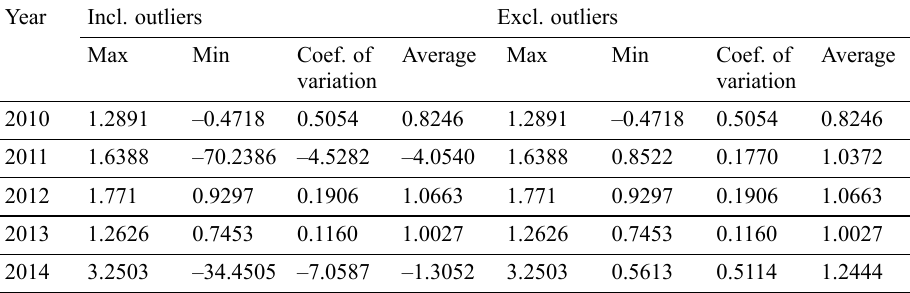
Table 3. Selected characteristics of yield variator Year Incl. outliers Excl. outliers Max Min Coef. of Average Max Min Coef. variation